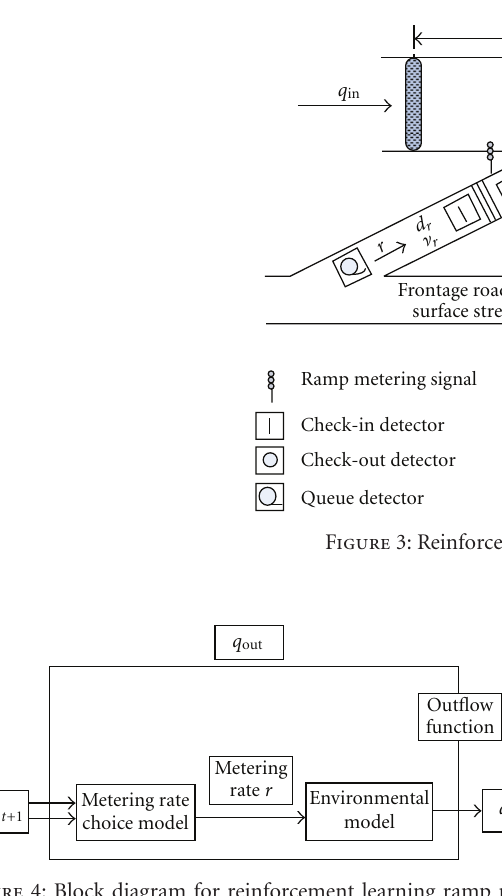
Figure 4: Block diagram for reinforcement learning ramp meter-